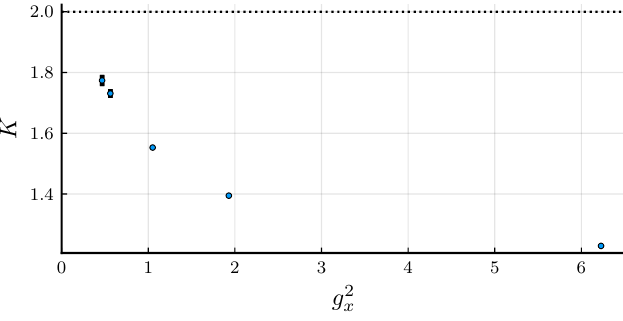
Figure 8 . The running Luttinger parameter K as a function of the coupling g 2 the error measure σ K as defined in the text. The dotted line indicates the expected continuum behaviour and for sufficiently small couplings we see a clear trend towards this